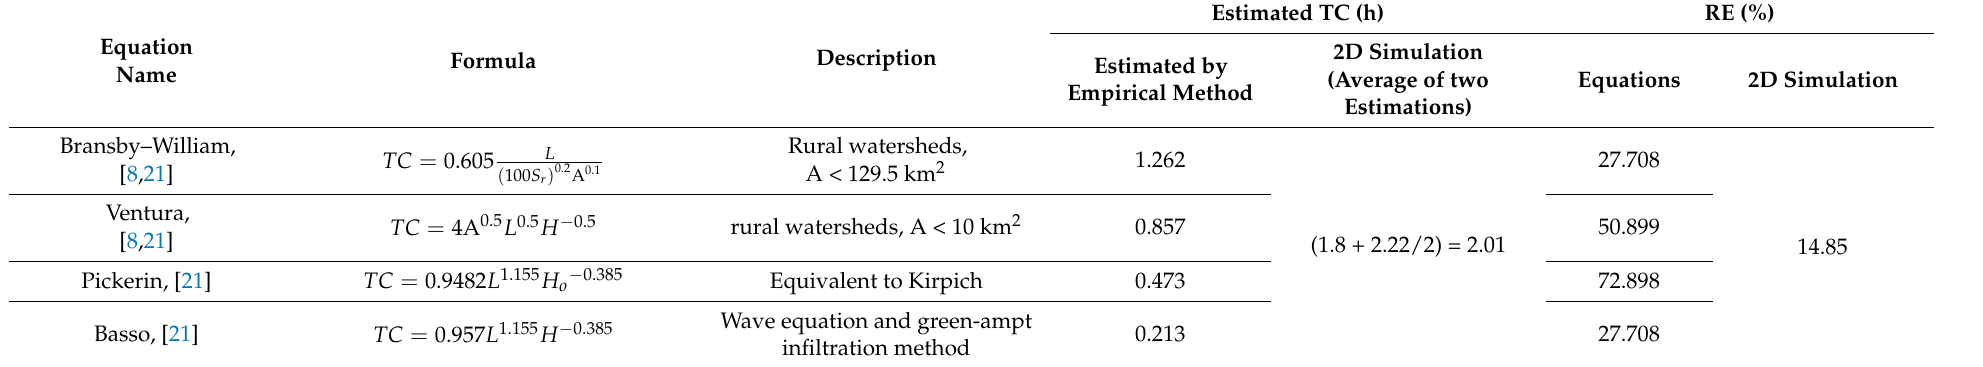
Table 5. TC (h) and RE (%) for methods based on Elevation (category IV).